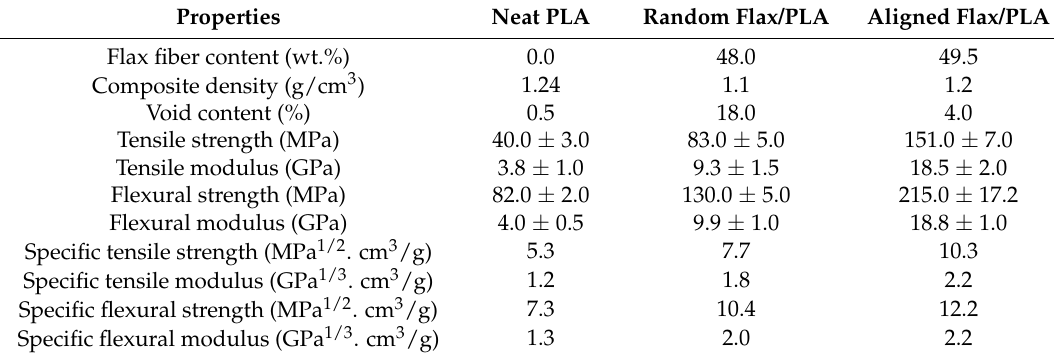
Table 3. Physical and mechanical properties of unreinforced PLA and the composites. Properties